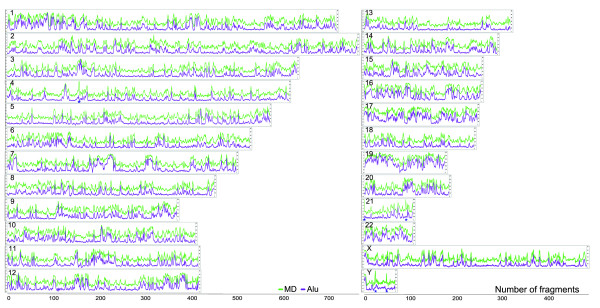
Multifractal map of the human genome. Overview between the MD (green) and Alu density (purple) across the human chromosomes. (*): VSTRs.